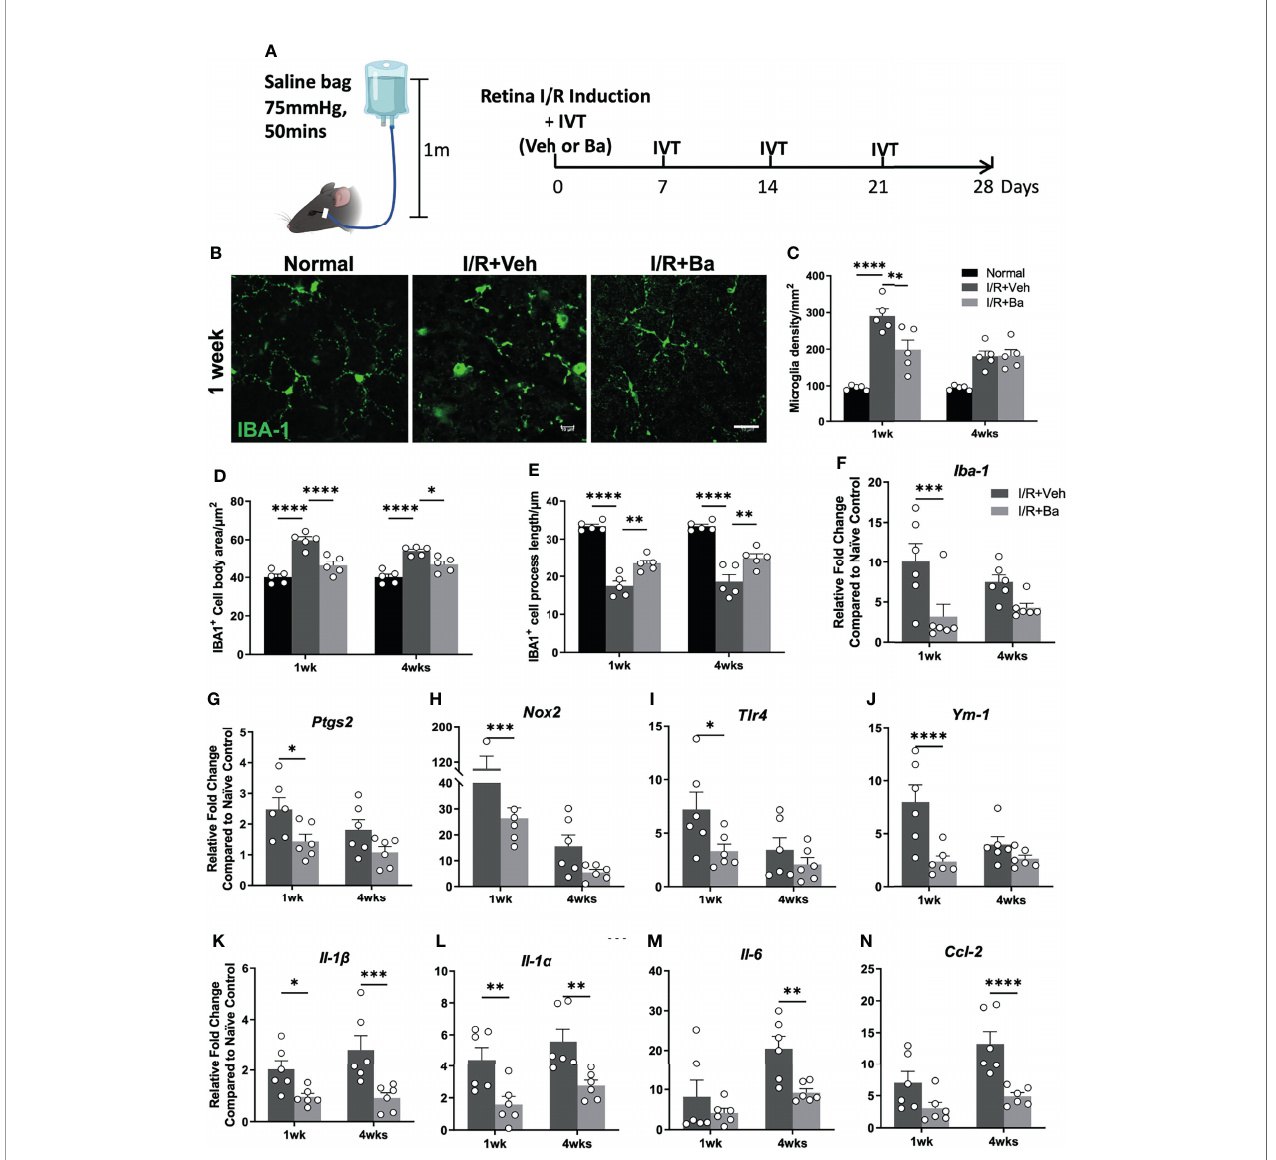
FIGURE 4 | Baicalein alleviates retinal ischemia/reperfusion (I/R) injury-induced retinal microglia activation and neuroin fl ammation. (A) Schematic illustration of the mouse I/R model and the frequency of intravitreal (IVT) injection of vehicle (Veh) or baicalein (Ba). (B) Representative immuno fl uorescence images of IBA-1-labeled microglial cells (green) on fl at mount retina from normal, vehicle (Veh), or 100 m M baicalein (Ba)-treated mice at 1 week post-I/R. Scale bar = 20 m m. Quanti fi cation of (C) microglial density, (D) cell body area, and (E) process length of Iba-1-positive cells ( N = 5 per group). qPCR analysis of activated microglia markers (F – J) and pro-in fl ammatory cytokines (K – N) in Veh or Ba-treated mice (relative fold changes normalized to naive control) at 1 and 4 weeks post-I/R injury ( N = 6 per group). Data were presented as mean ± SEM. Each dot represented individual replicate. * P < 0.05, ** P < 0.01, *** P < 0.001, **** P < 0.0001, two-way ANOVA with S ̌ ı ́ da ́ k ’ s multiple comparisons